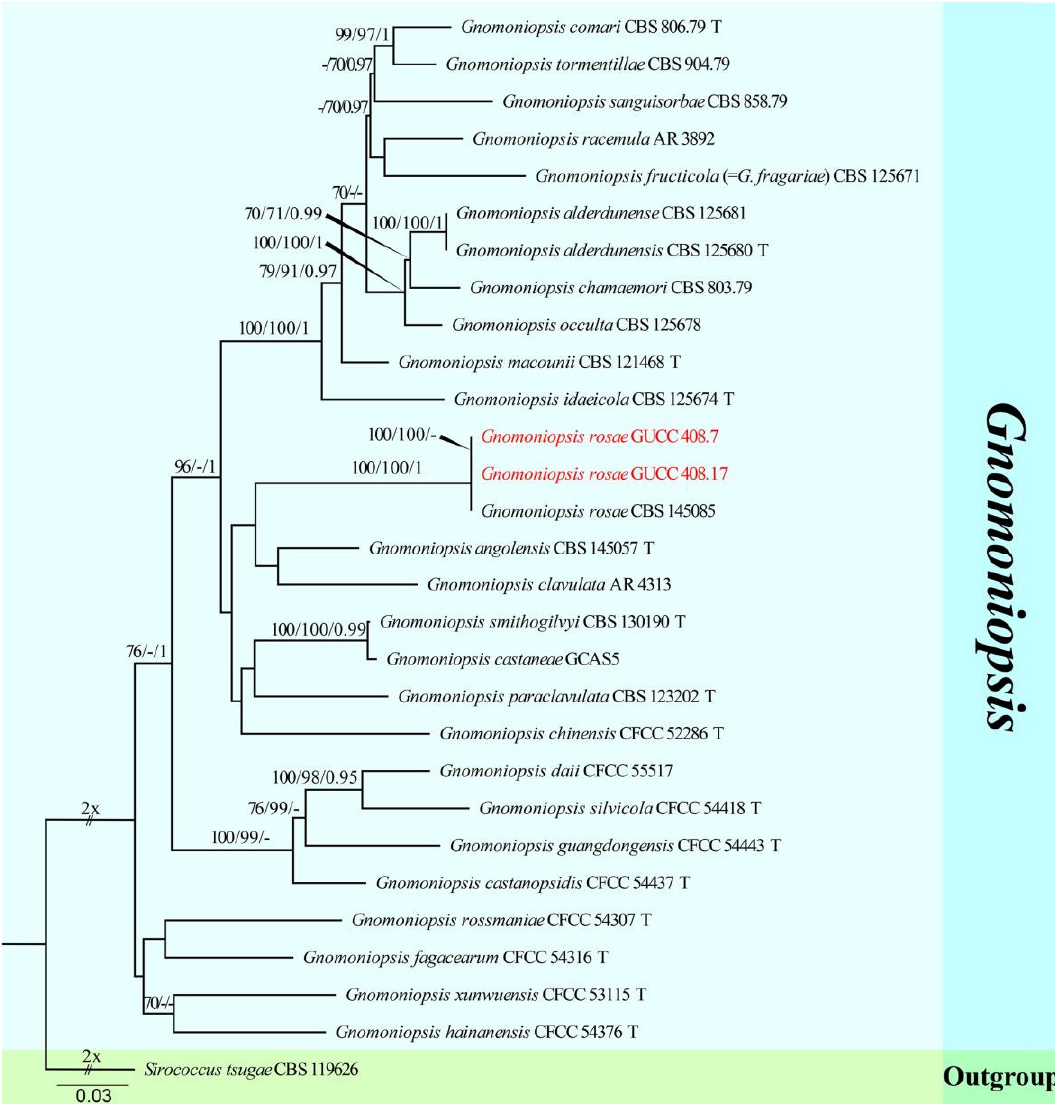
Figure 4. Phylogram generated from RAxML analysis of a concatenated ITS-LSU- rpb2 - tef1 - tub2 sequence dataset to represent the phylogenetic relationships of taxa in Gnomoniopsis . The tree was rooted with Sirococcus tsugae (CBS 119626). Bootstrap support values for ML and MP equal to or greater than 70% and the Bayesian posterior probabilities equal to or higher than 0.95 PP are indicated above the nodes as ML/MP/PP. Support values lower than 70% ML/MP and 0.95 PP are indicated by a hyphen (-). The newly generated sequences are indicated in red.